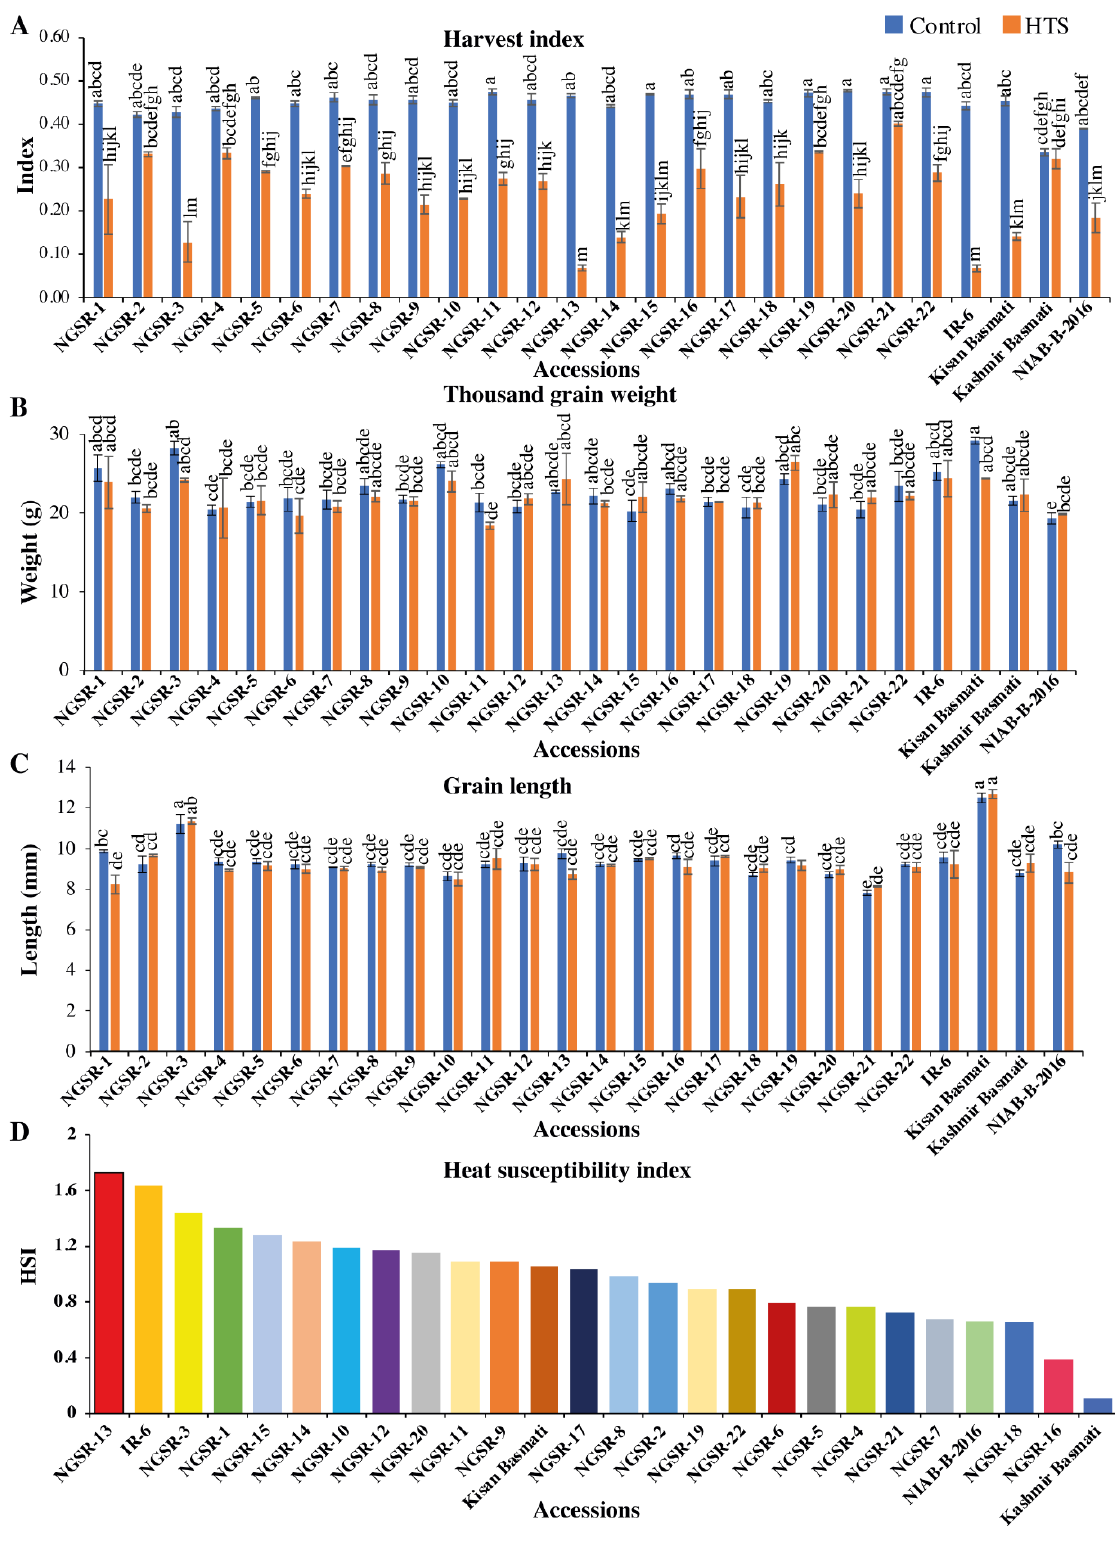
Figure 3. Evaluation of 22 GSR lines and four control types under control and heat stress. Data for harvest index per plant ( A ), thousand grain weight ( B ), and grain length ( C ) were recorded under both conditions. Tuckey’s test was used for statistical differences. Different letters above the column varied significantly at p < 0.05. ( D ) Distribution of heat susceptibility index for grain yield .